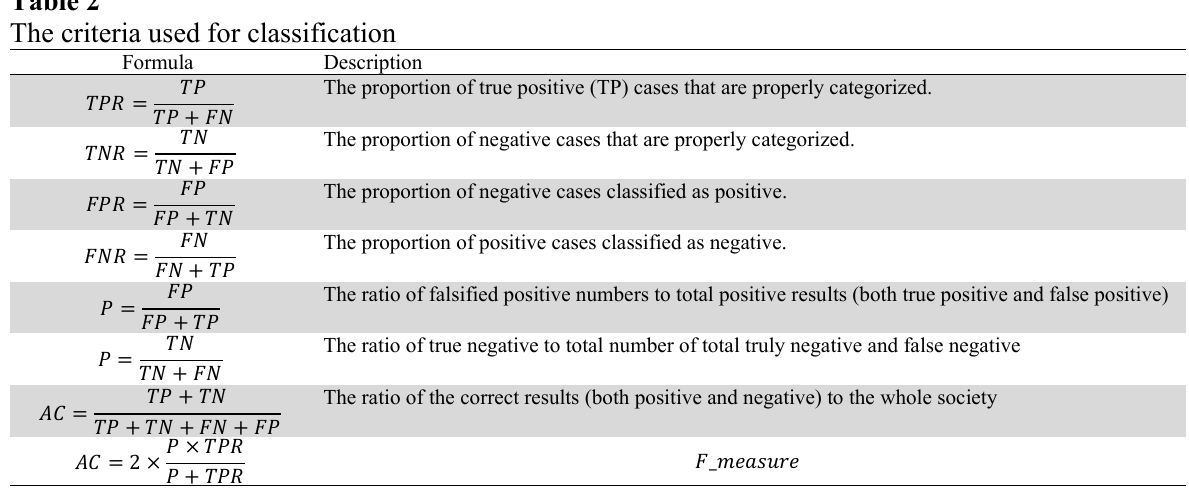
The criteria used for classification